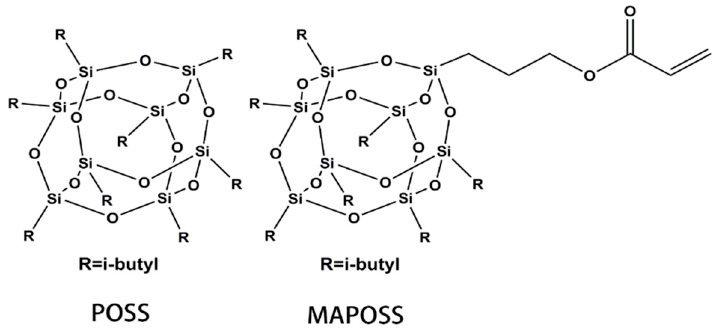
Figure 1. The structure of POSS and MAPOSS.